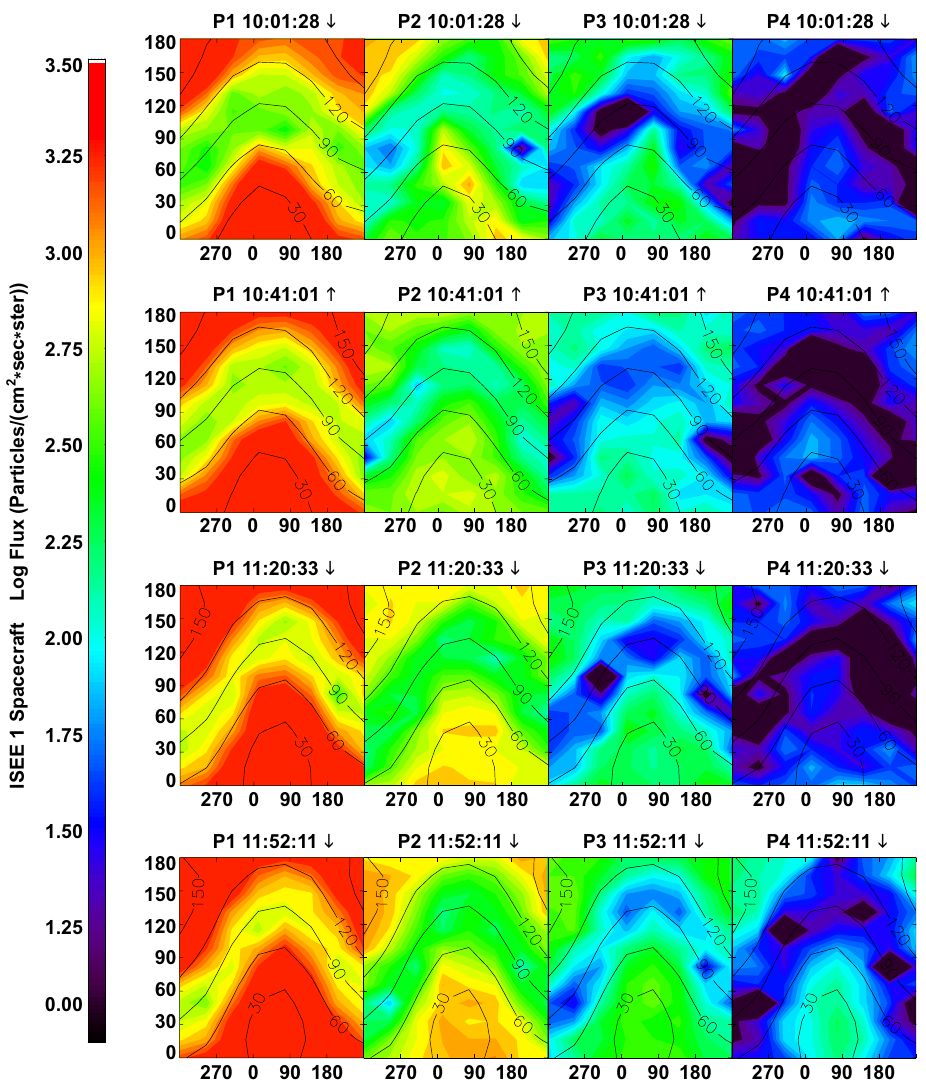
Fig. 7. The 3-D proton PADs for channels P1, P2, P3, and P4 (four columns) at four different times (four rows for 10:01:28,